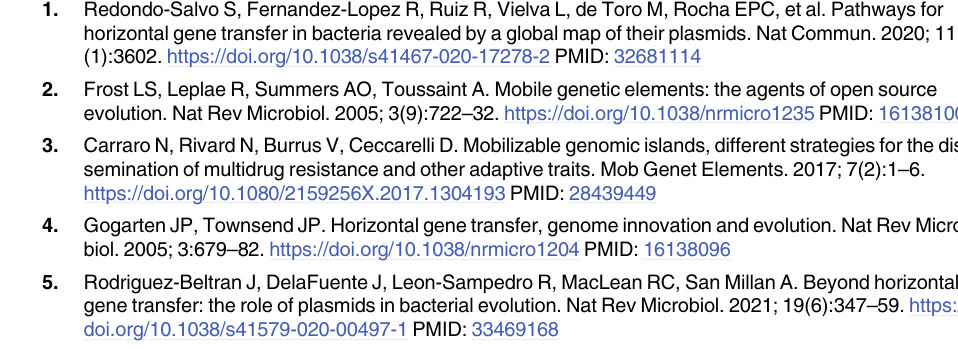
S4 Data. Source data for Fig 6. Dependency of ICE clc promoters on ICE global regulators, RNA-seq and expression data. S5 Data. Source data for Fig 7. ICE clc transfer data.